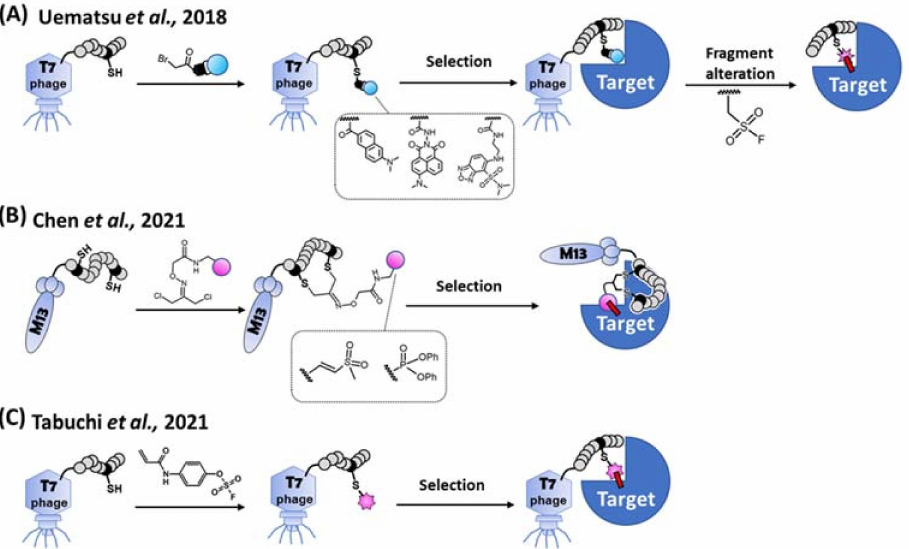
Figure 6. Methods for the combinatorial screening of peptidic covalent binders. ( A ) Indirect screening. Library peptide on the T7 phage is modified by each bait fragment (i.e., unreactive mock warhead), respectively. After the selection of a target protein, a consensus sequence of a peptide is